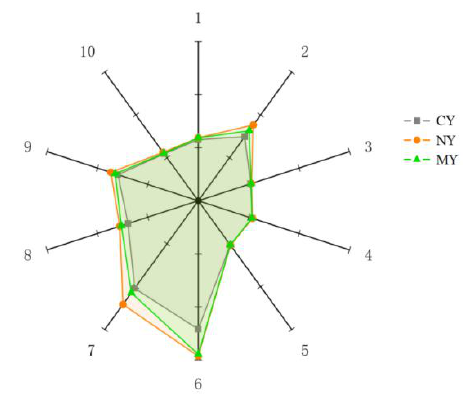
Figure 9. Aroma radar map of different yogurts.